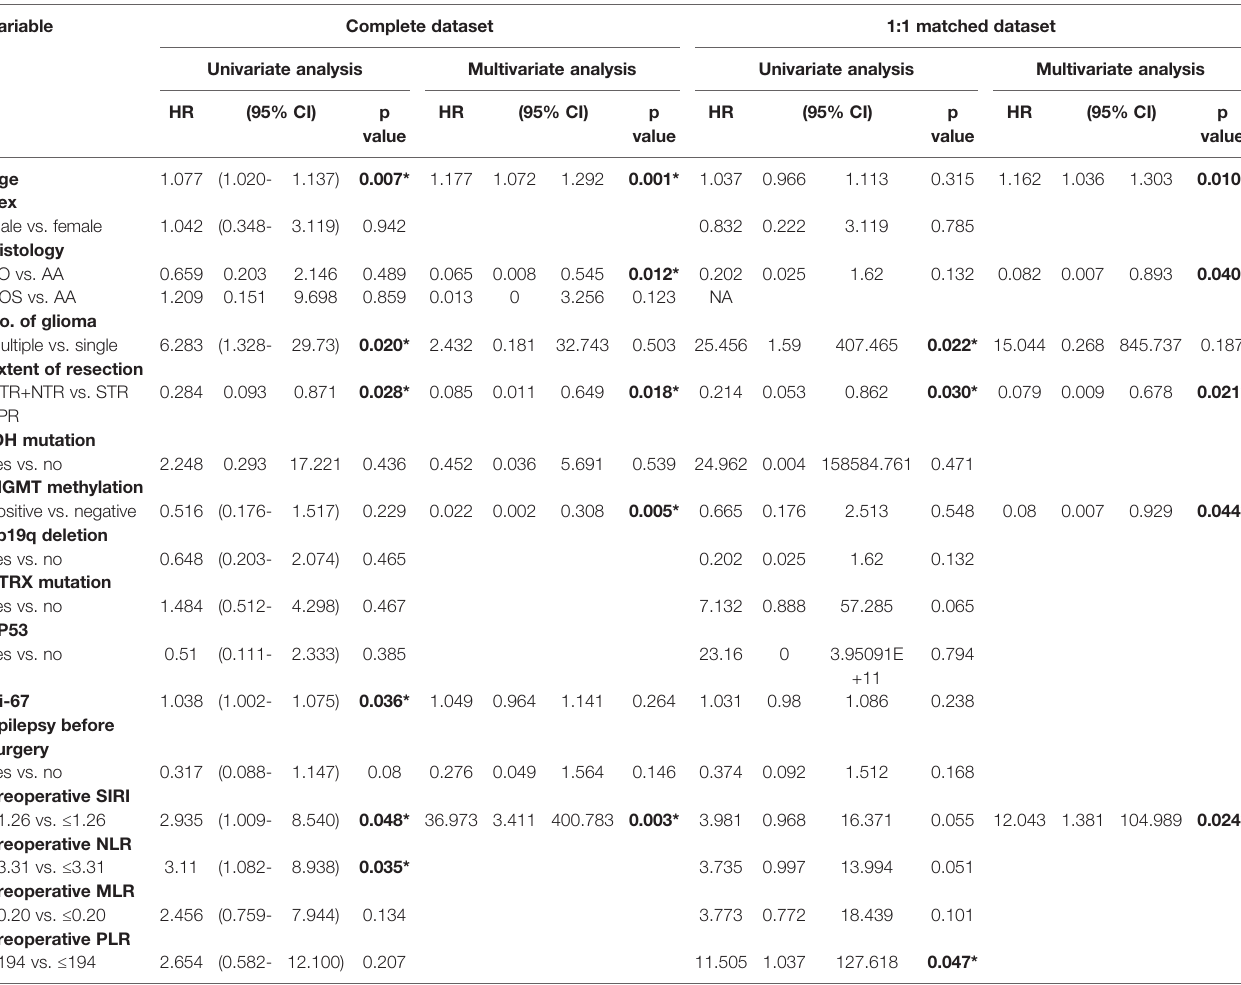
TABLE 5 | Univariate and multivariate cox regression analyses for overall survival in grade III glioma.